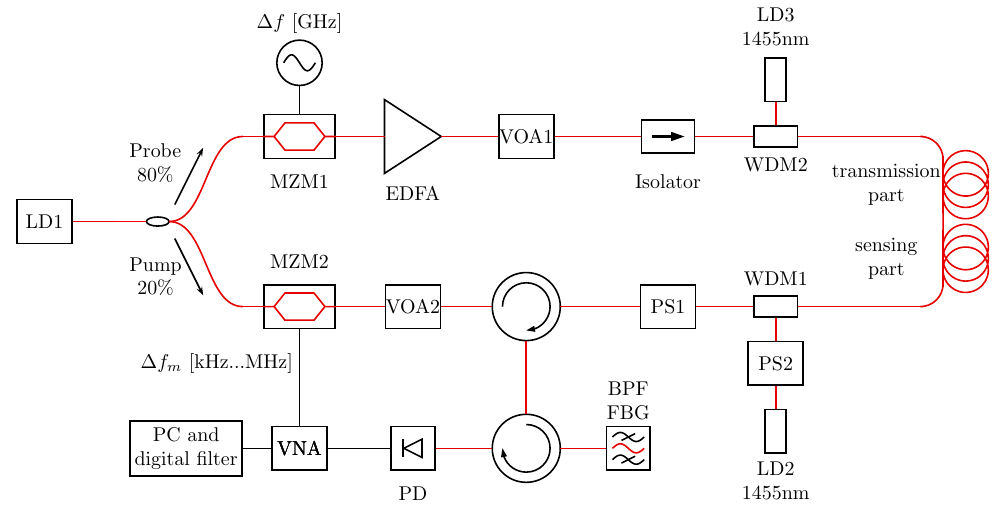
Figure 1. BOFDA sensor setup, LD: laser diode; MZM: Mach-Zehnder modulator; EDFA: Erbium-doped fiber amplifier; VOA: variable optical attenuator; PS: polarization scrambler; SMF: single mode fiber (for detailed configuration see Figure 2) ; BPF FBG: bandpass filter based on fiber Bragg grating; PD: photo diode; VNA: vector network analyzer, WDM: wavelength division multiplexer.